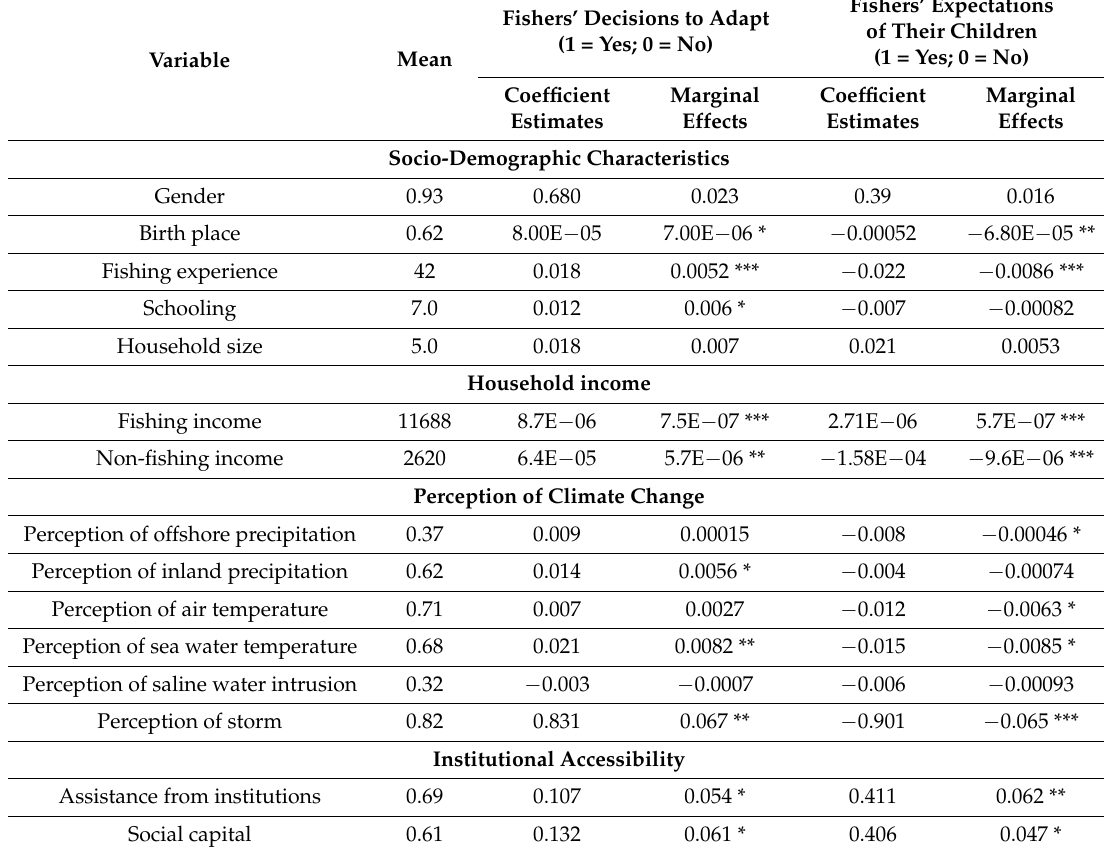
Table 2. Fishers’ decisions to adapt, and expectations of their